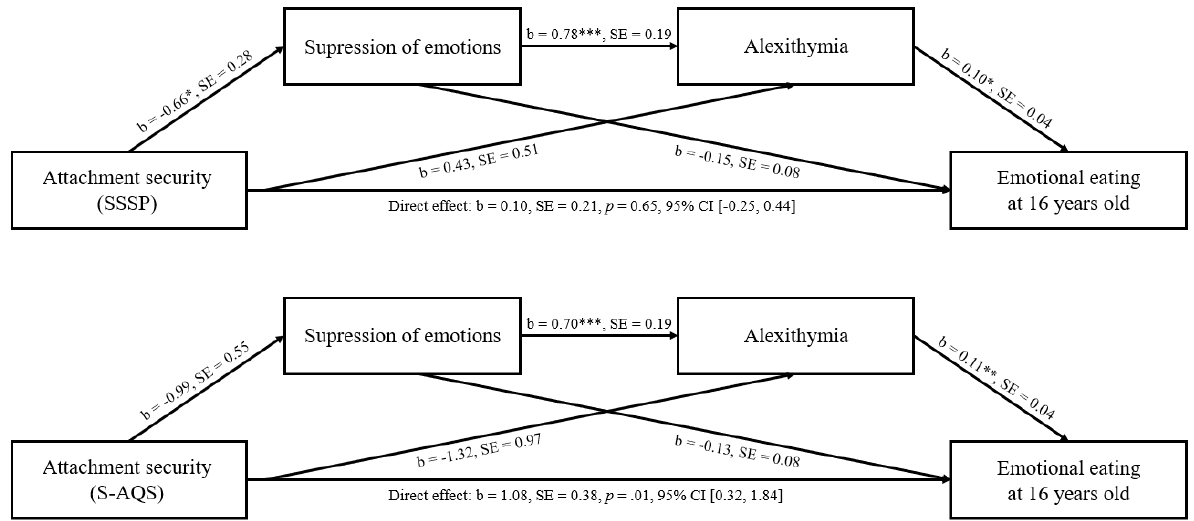
Figure 3. Suppression of emotions and alexithymia as mediators between attachment security and emotional eating at the age of 16 years old. Notes. * p < 0.05; ** p < 0.01; *** p < 0.001. b = unstandardized regression coefficients; SE = standard errors; SSSP = shortened strange situation procedure, S-AQS = shortened attachment Q-set.